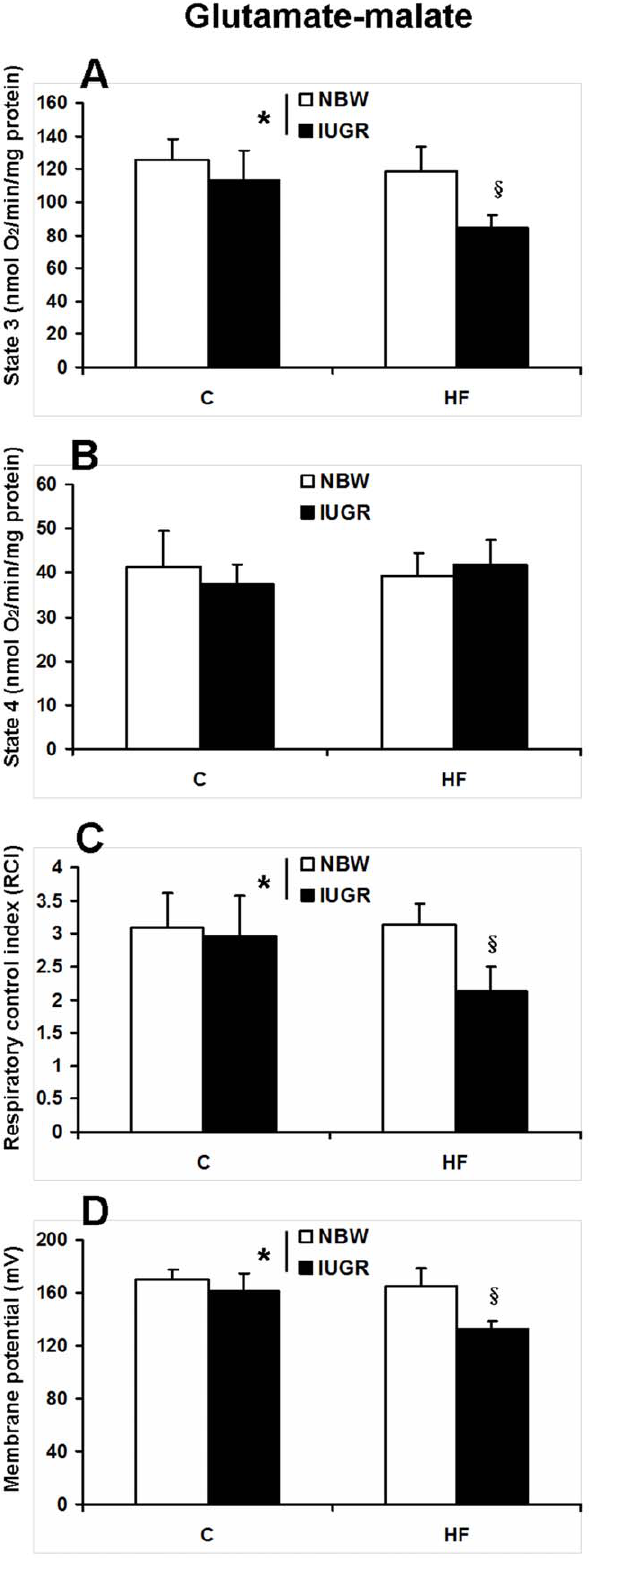
Figure 6. Influence of IUGR and diet on mitochondrial respiratory activities and membrane potential in skeletal muscle of pigs. Glutamate-malate or succinate was used as the oxidative substrate. C: Control diet; HF: High-fat diet; NBW: Normal birth weight; IUGR: Intrauterine growth retardation. Data are expressed as group means 6 SEM. * P values next to each label represent the significance in the effect for each source of variation (IUGR or diet) as calculated by ANOVA. 1 P , 0.05 in post hoc test comparing IUGR and NBW offspring receiving the same diet (n=8 by group). doi:10.1371/journal.pone.0034835.g006 PLoS ONE |